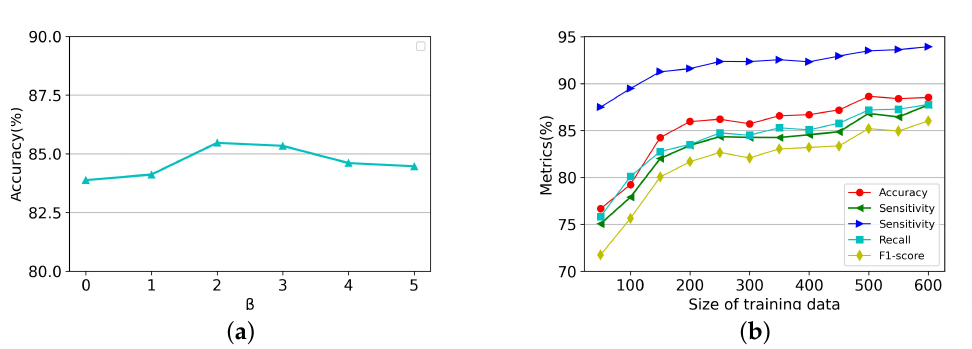
Figure 3. Illustrating ( a ) classification accuracy of the proposed method on different values of β in the 60-label case and ( b ) classification performance of the proposed method on different sizes of training